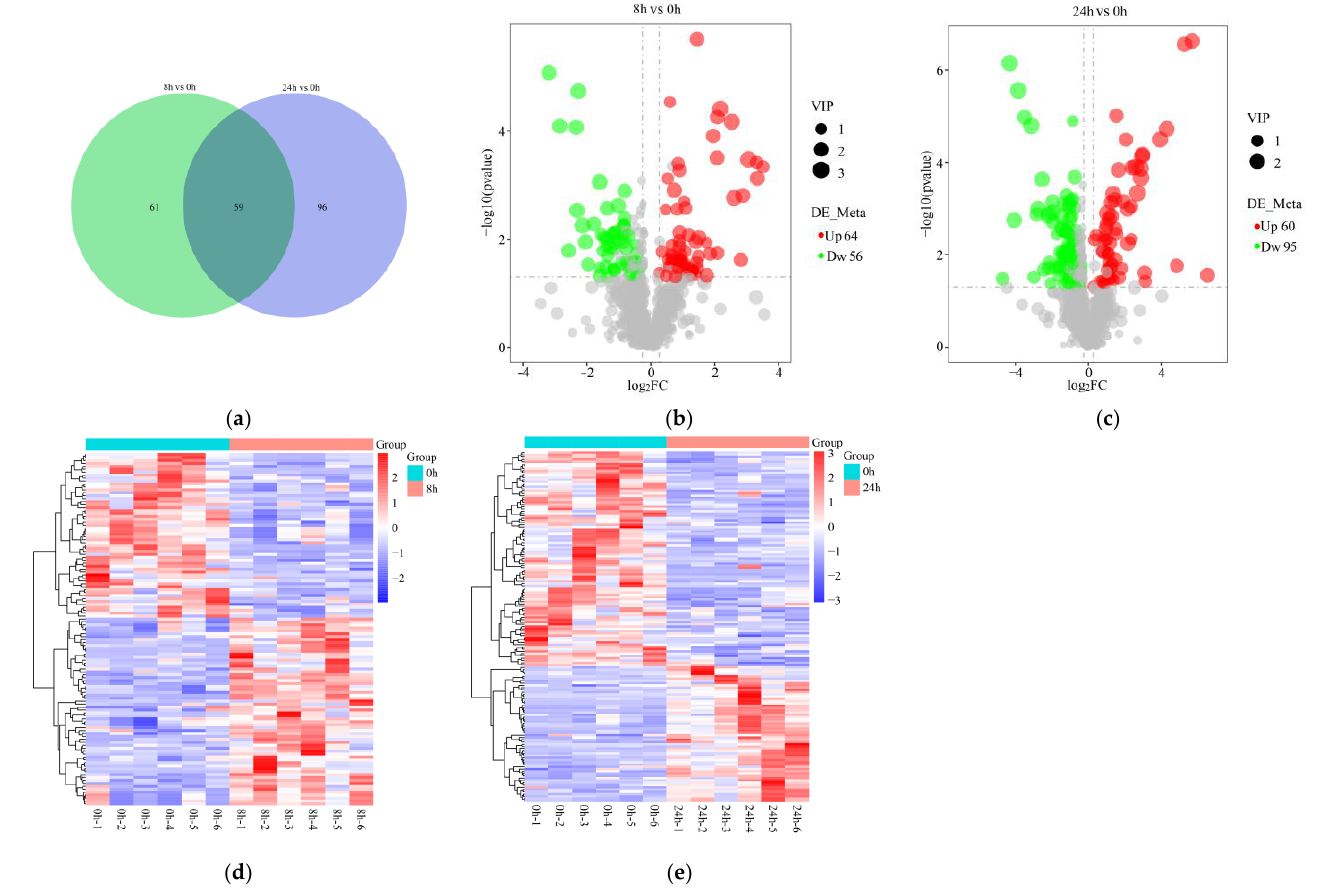
Figure 5. Statistical analysis of differentially expressed metabolites (DEMs) in the roots of orchardgrass under submergence stress. ( a ) Venn diagram of the number of DEMs. Volcanic map of up- and down-regulated DEMs in roots of orchardgrass at 8 h vs. 0 h ( b ) and 24 h vs. 0 h ( c ). Heat map of DEMs in root at 8 h vs. 0 h ( d ) and 24 h vs. 0 h ( e ).